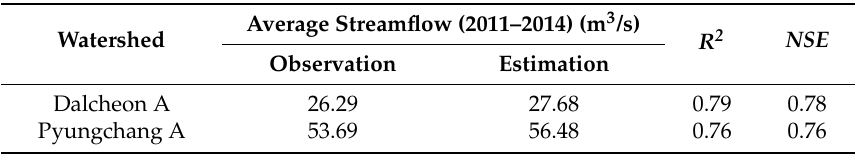
between 2011 and